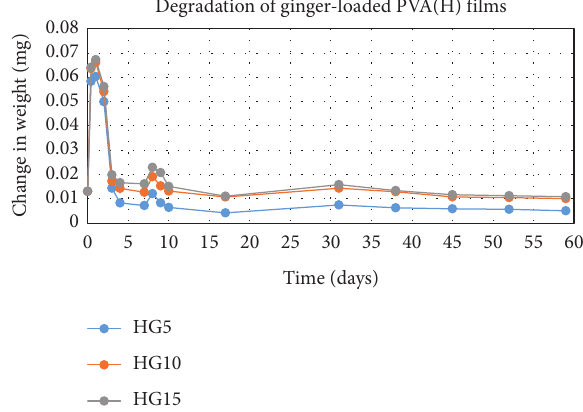
Figure 8: Degradation of ginger-loaded PVA (H) films.